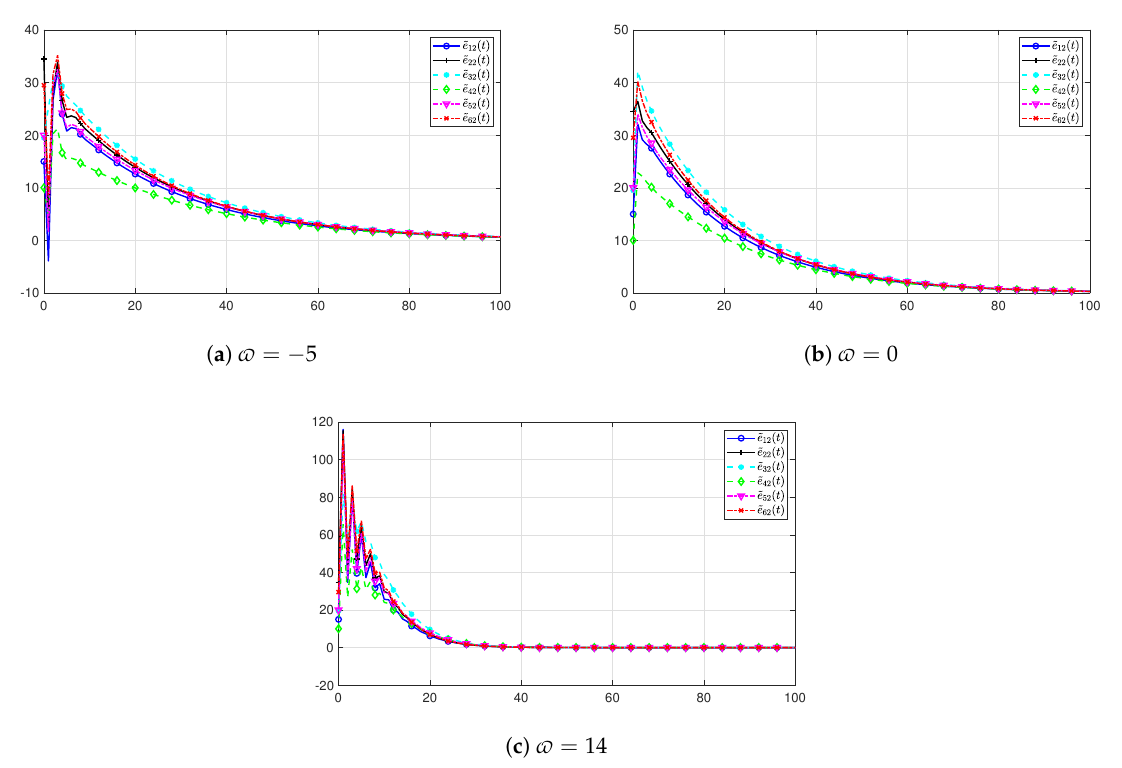
Figure 15. The simulation of ˜ e i 2 ( k ) with different disturbances of component D